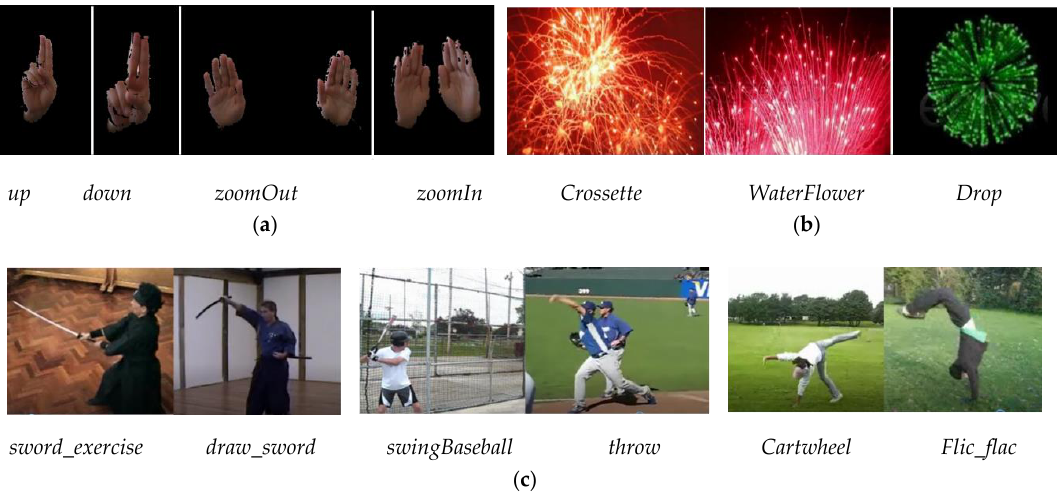
Figure 10. Instances of misclassified samples from ( a ) the hand gestures dataset; ( b ) the fireworks dataset; and ( c ) the HMDB51 dataset.